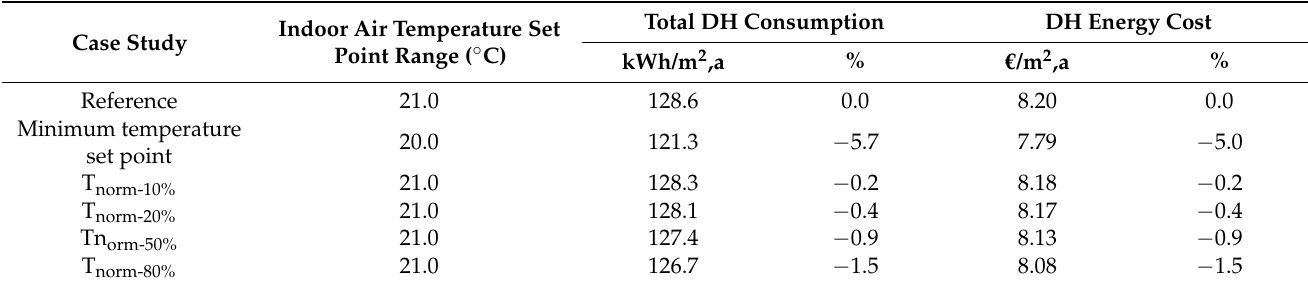
Table 5. DH consumption and cost per year by using the centralized DR